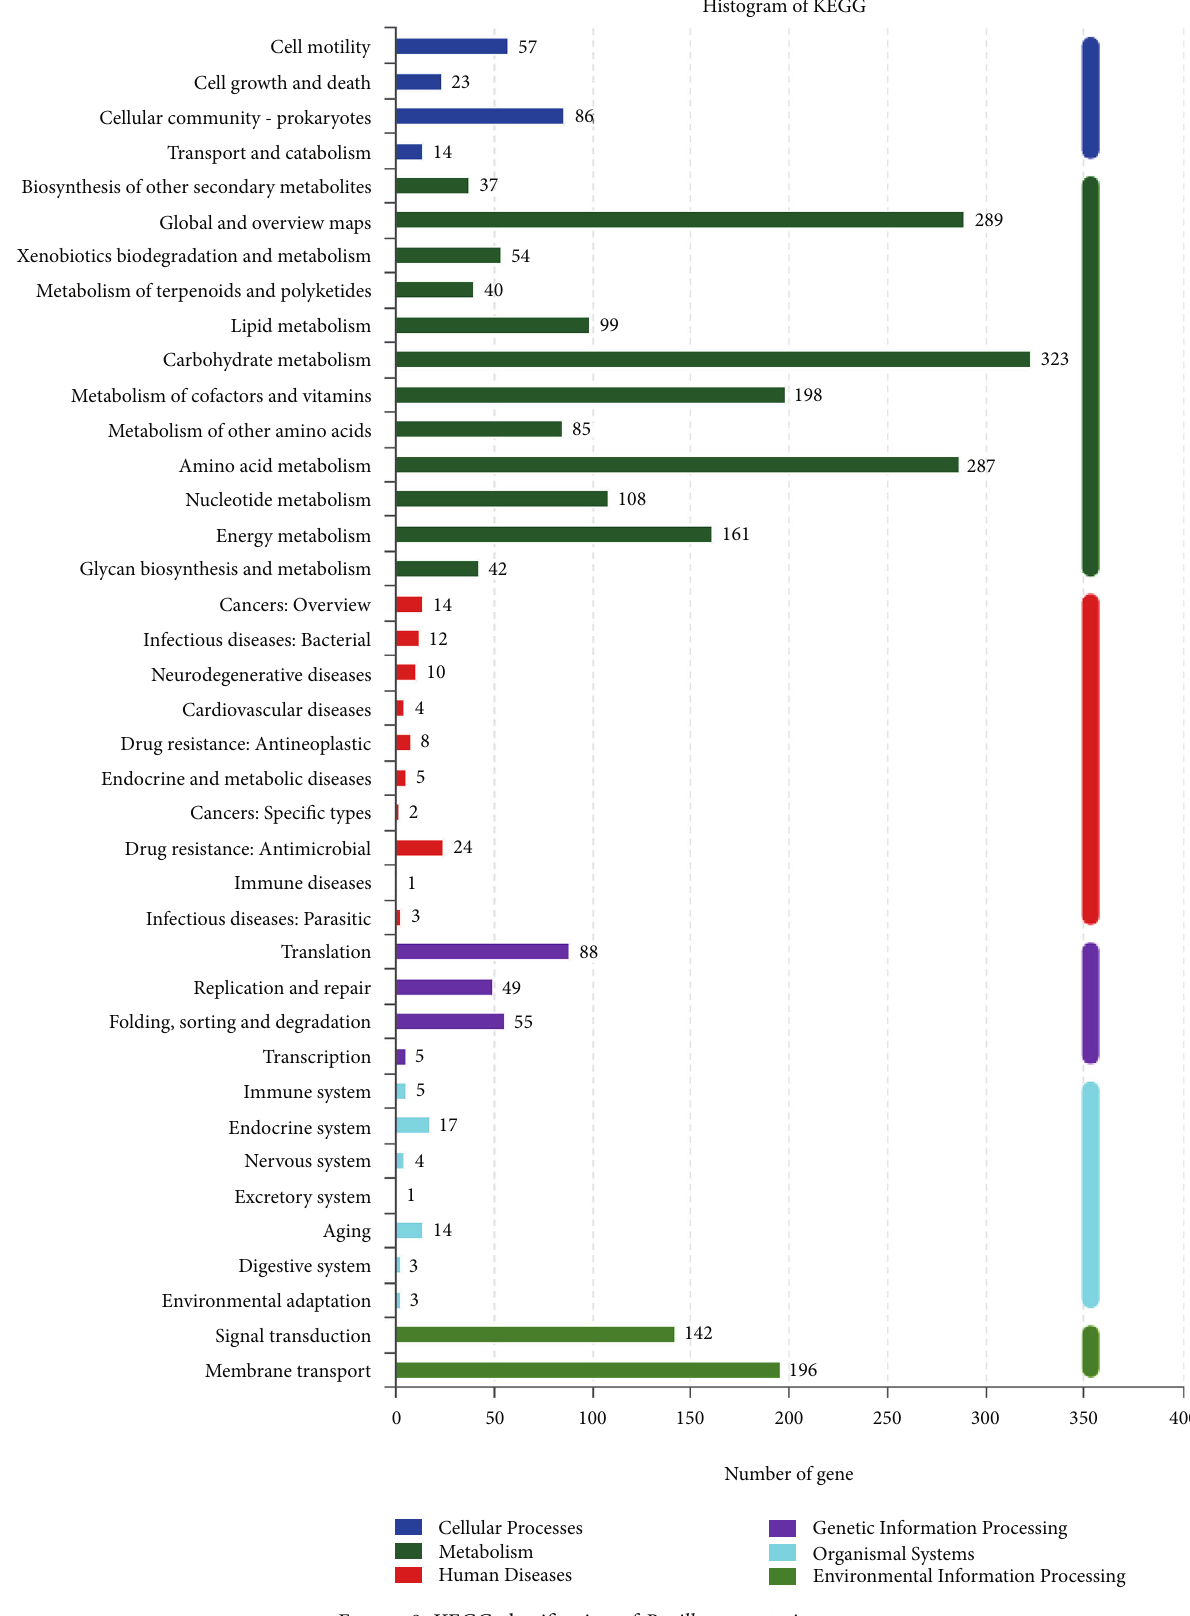
Figure 8: KEGG classi fi cation of Bacillus megaterium